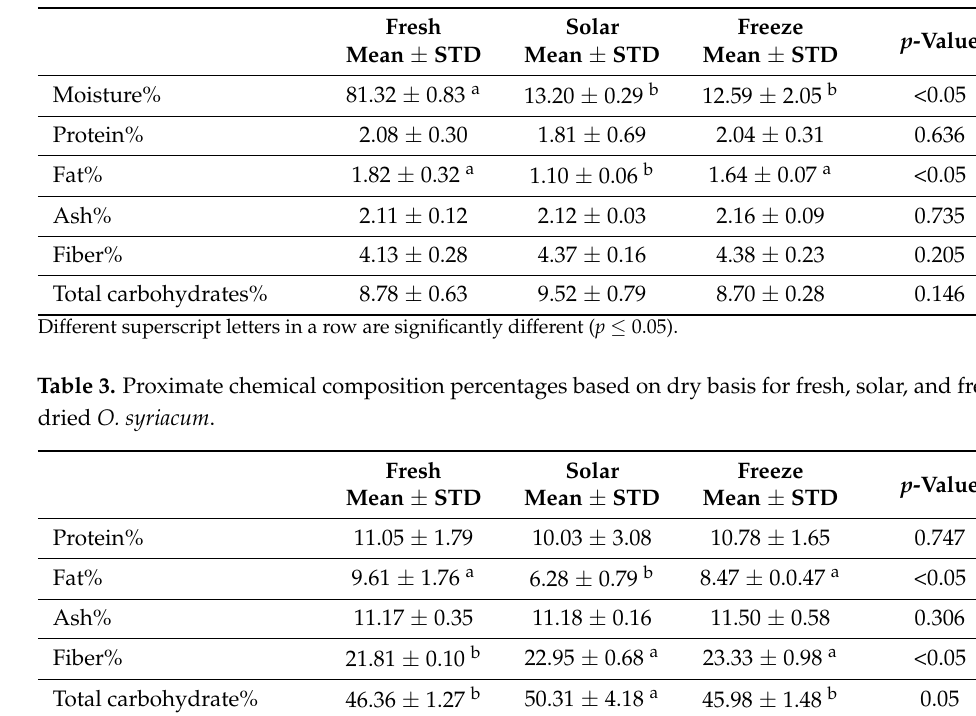
Table 2. Proximate chemical composition percentages based on wet basis for fresh, solar, and freeze- dried O. syriacum .